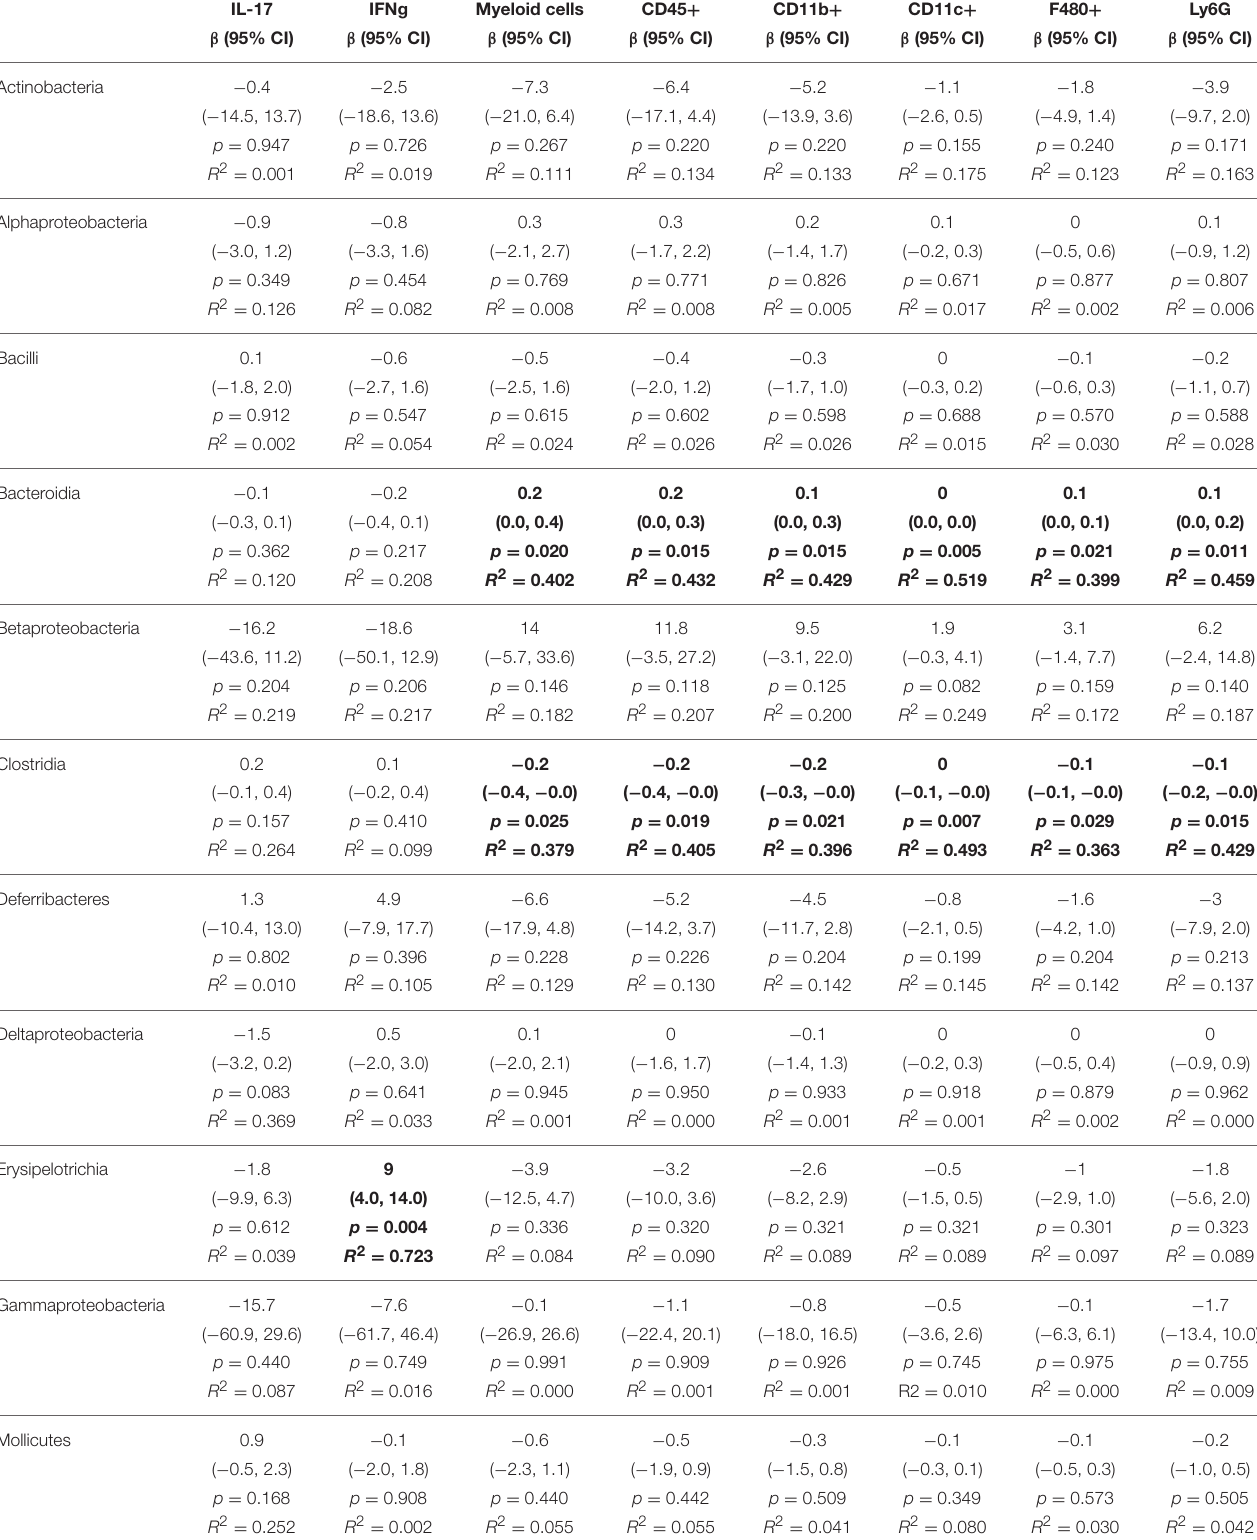
TABLE 5 | Associations from linear regression models between gut microbiota and alterations of adaptive immune system parameters measured in the